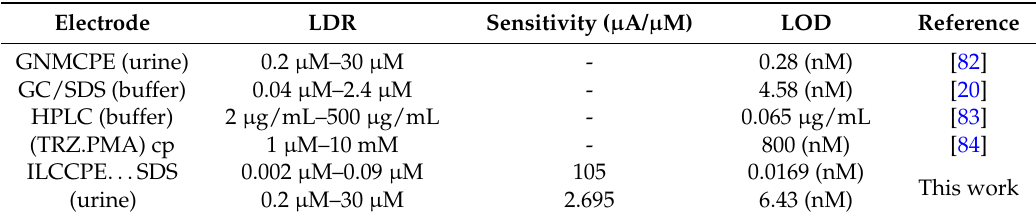
Table 4. Evaluation of the accuracy and precision of the proposed method for the determination of TZ in urine